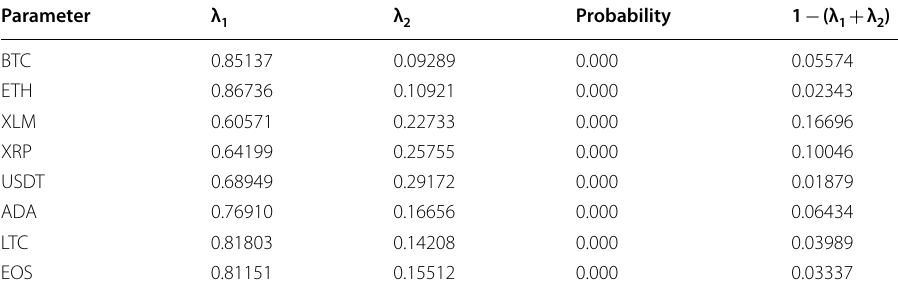
Table 6 Maximum Likelihood estimates of the Gaussian DCC model